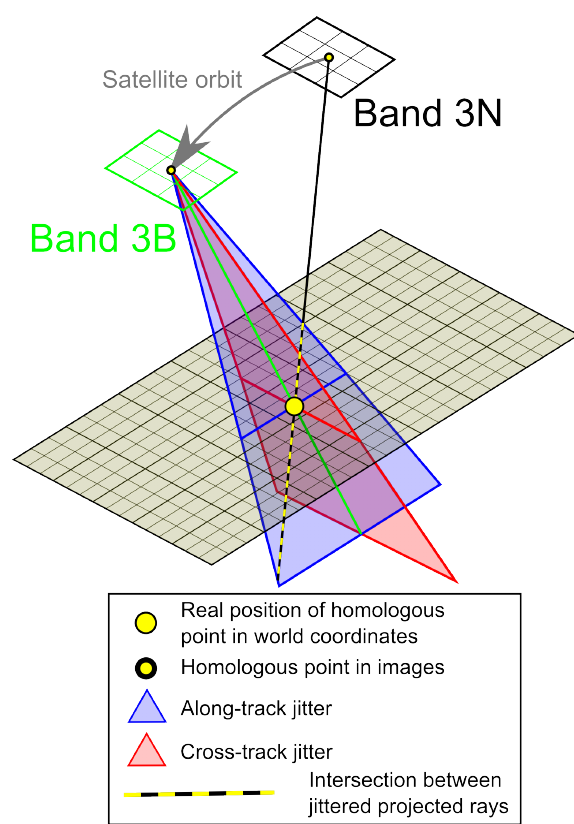
Figure 7: Effect of the jitters on the direction of the perspective ray of the backlooking image (Nadir image considered stable).